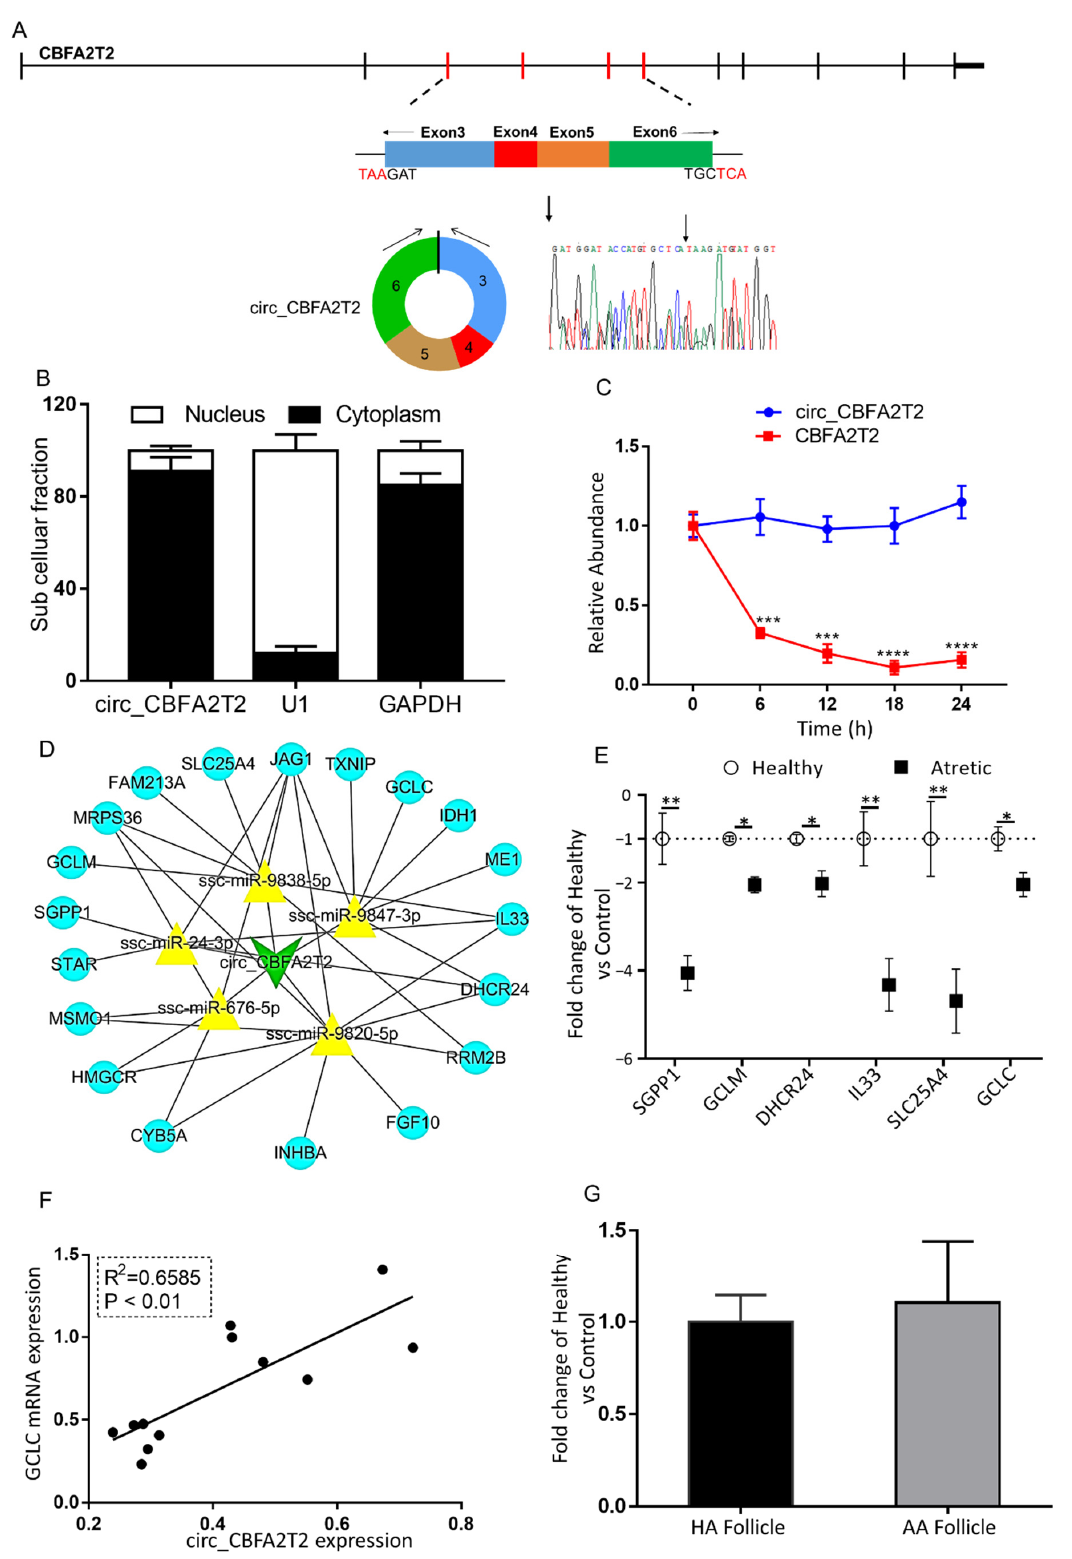
Figure 5. The characterization and putative role of circ_CBFA2T2. ( A ) The genomic loci of circ_CBFA2T2 in the CBFA2T2 gene. The expression of circ_CBFA2T2 was validated by qRT-PCR, followed by Sanger sequencing. Arrows represent divergent primers binding to the genome region of circ_CBFA2T2. ( B ) Cellular characterization of circ_CBFA2T2. Levels of nuclear control transcript